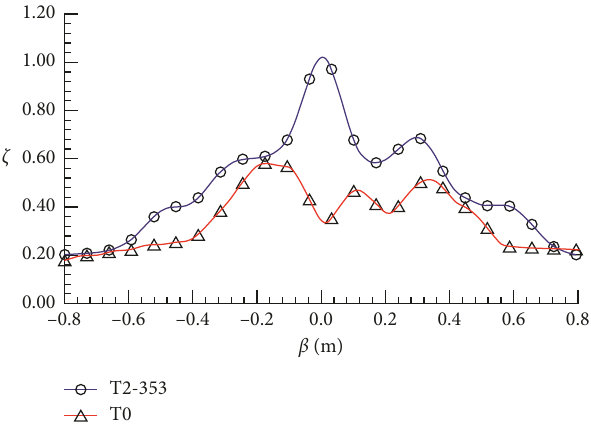
Figure 15: Variation of the dissipation rate on L test.